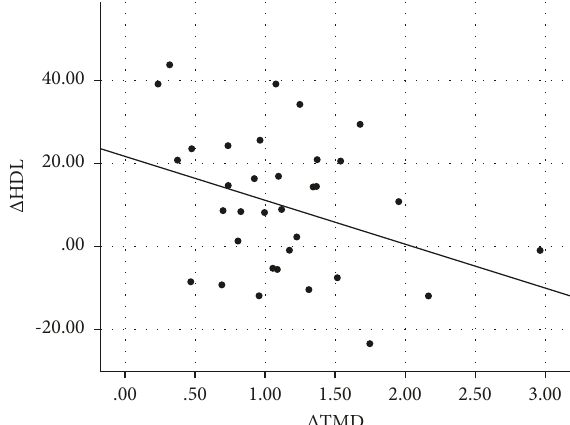
Figure 3: Scatter plot graph of values.